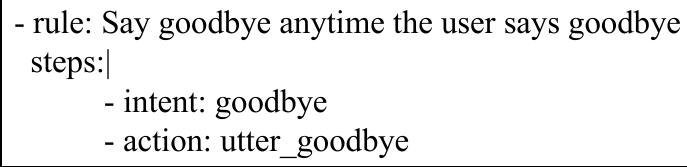
Figure 7. Example of dialogue management module dataset